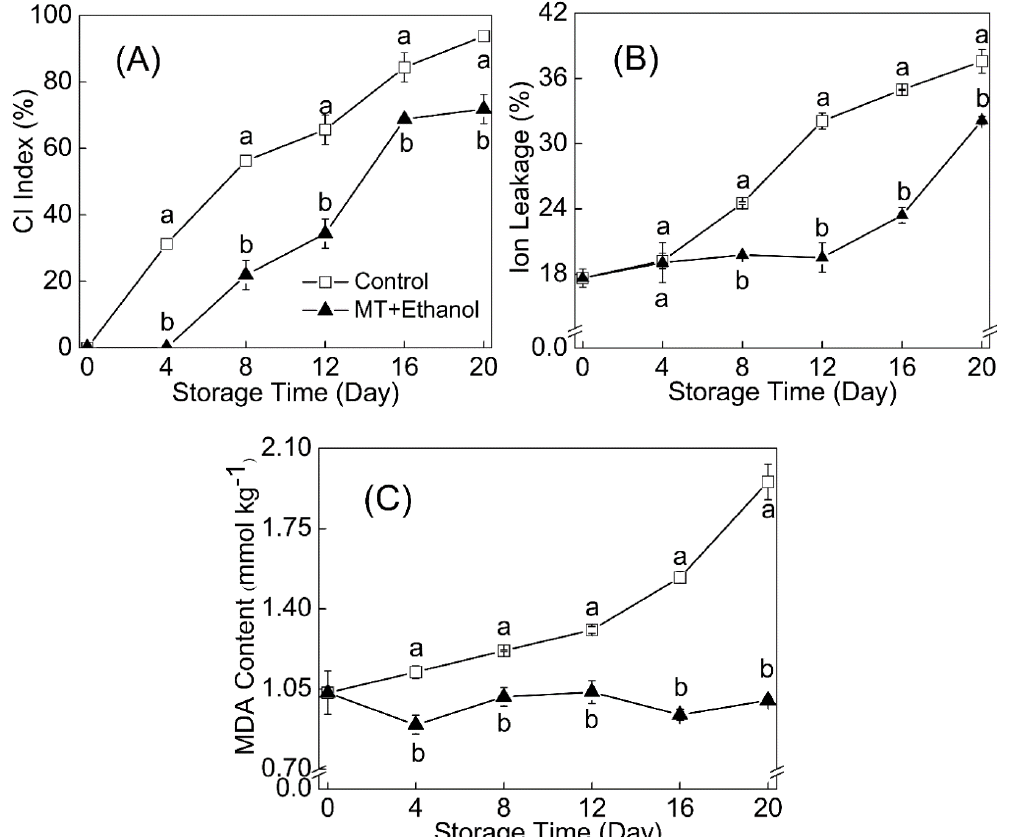
Figure 2. Effects of MT combined with ethanol treatment on CI index ( A ), ion leakage ( B ) and malondialdehyde (MDA) ( C ) content were presented. Results were expressed as mean ± SD of triplicate assays. Vertical bars represented the standard errors of the means. Significant differences ( p < 0.05) were represented by different letters.